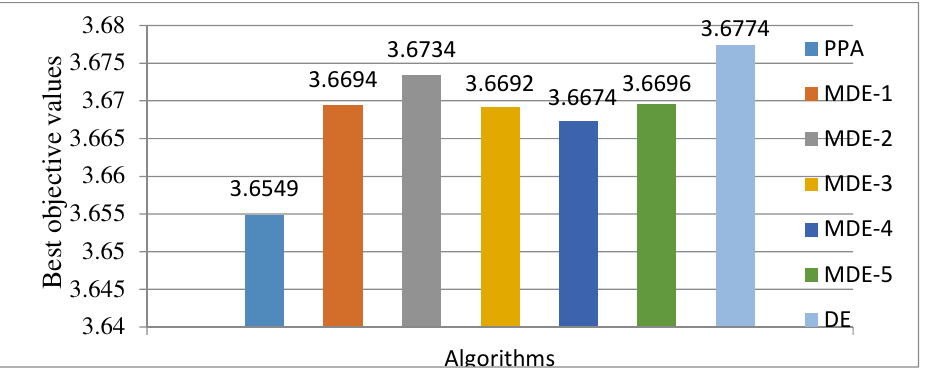
FIG. 5: NUMBER OF TOTAL FUNCTION EVALUATIONS TAKEN BY PPA, DE AND ITS VARIANTS IN SOLVING THE 3-BUS PROBLEM OF DOCRS.